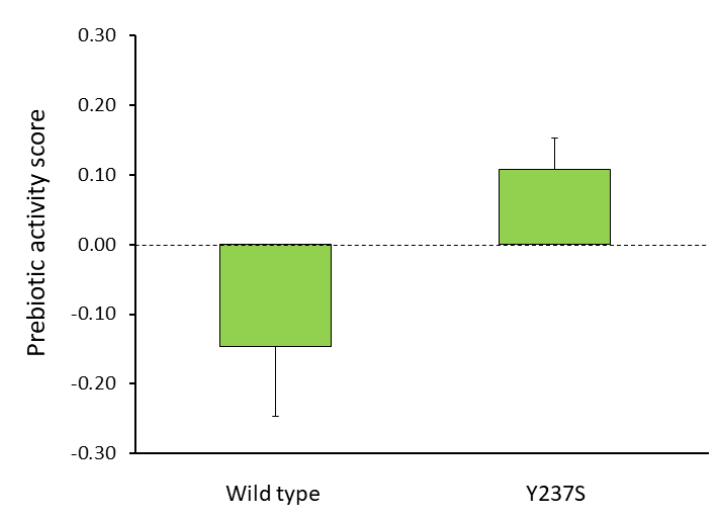
Figure 9. The prebiotic activity of levan and LFOS synthesized by wild-type and variant LsKK9.